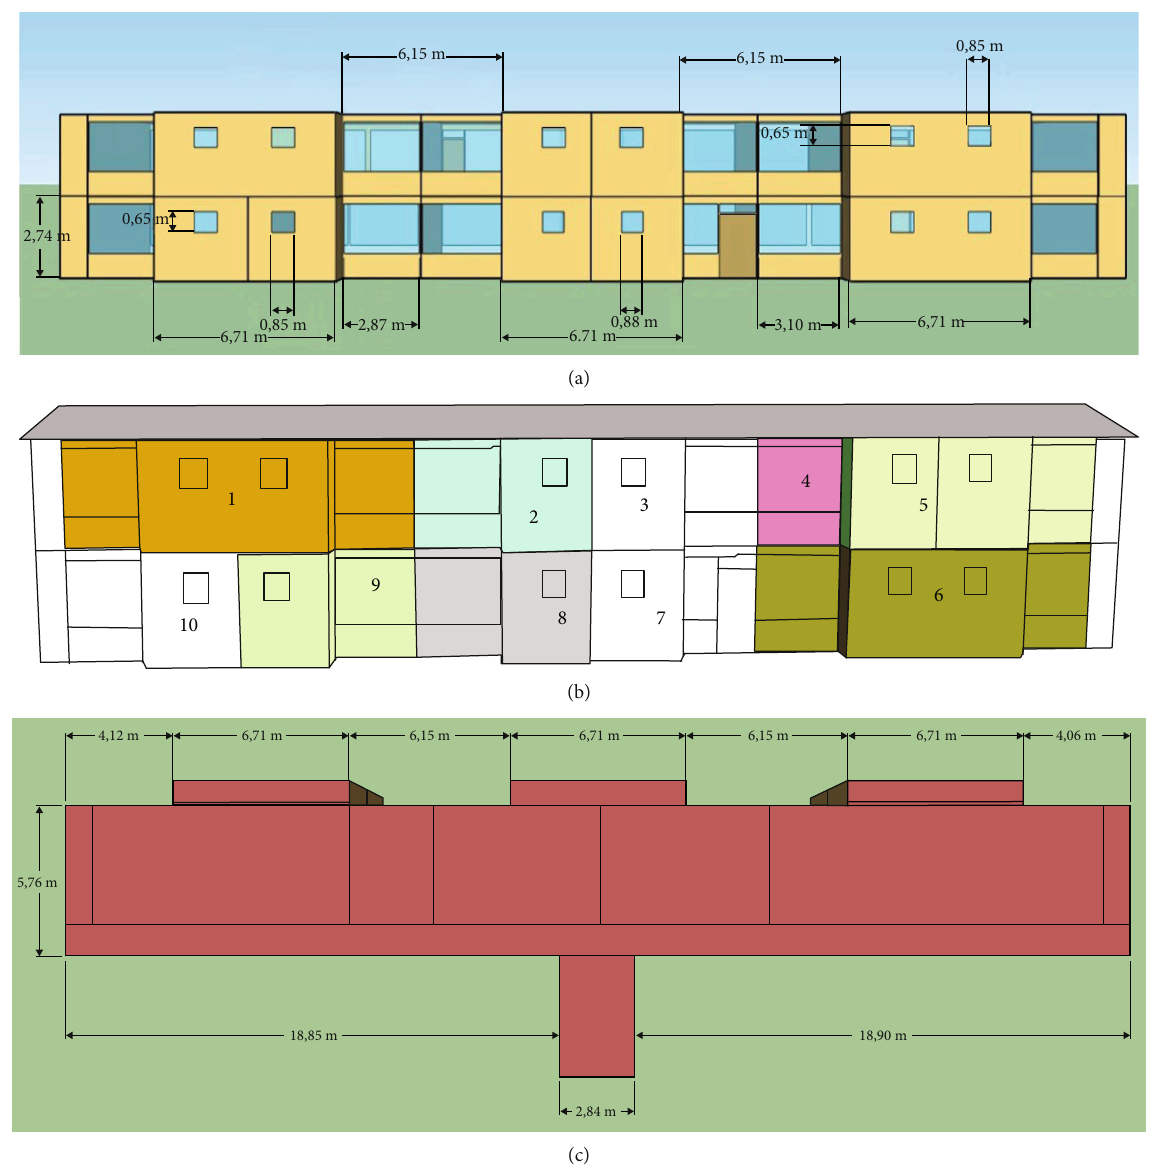
Figure 1: Modeled UENR administration block ((a) frontal view, (b) thermal zones and (c) top